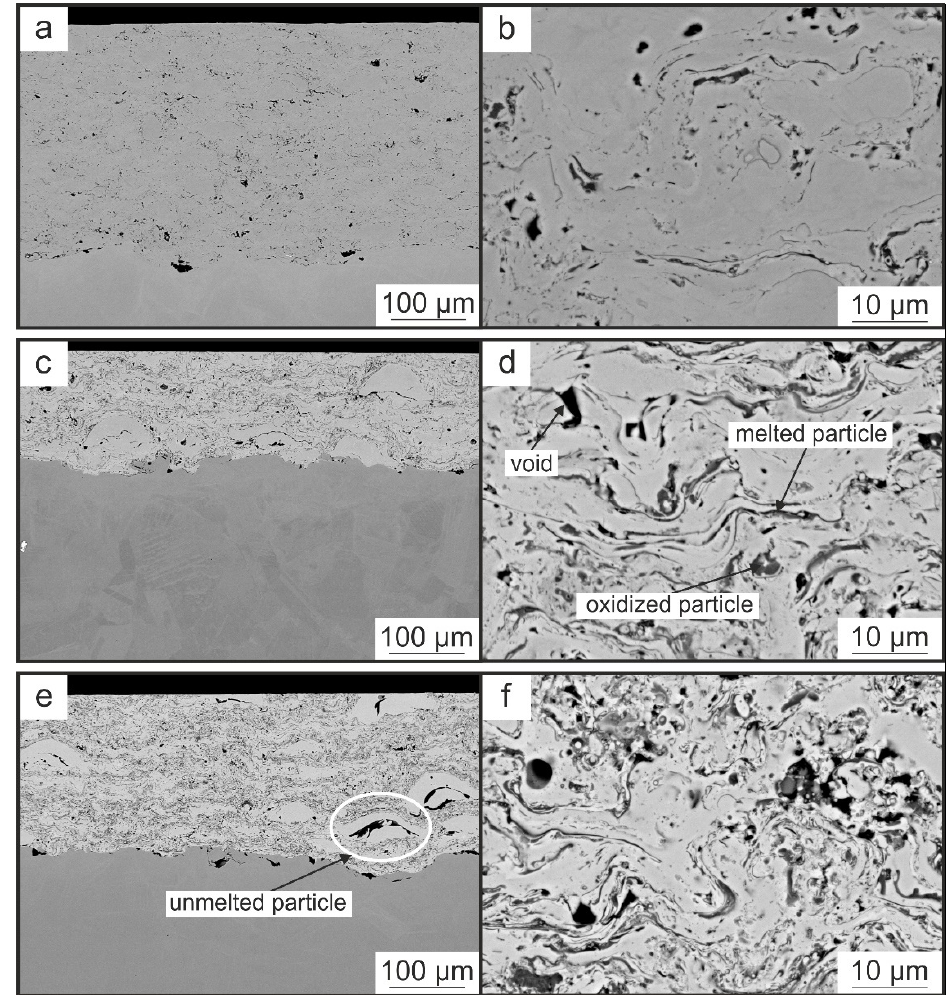
Figure 1. SEM images of HVOF-sprayed coatings: ( a , b ) Al 0.3 CrFeCoNi, ( c , d ) Al 0.3 CrFeCoNiNb 0.5 as well as ( e , f ) Al 0.3 CrFeCoNiMo 0.75 . Typical features of HVOF coatings were observed: unmelted particles, melted particles (splats), oxidized particles and voids. In contrast to HVOF-sprayed Al 0.3 CrFeCoNi coating ( b ), the HVOF-spayed coatings with Nb ( d ), and Mo ( f ) show a higher proportion of oxidized lamellae, which have a darker gray-scale than the solid solution phase.